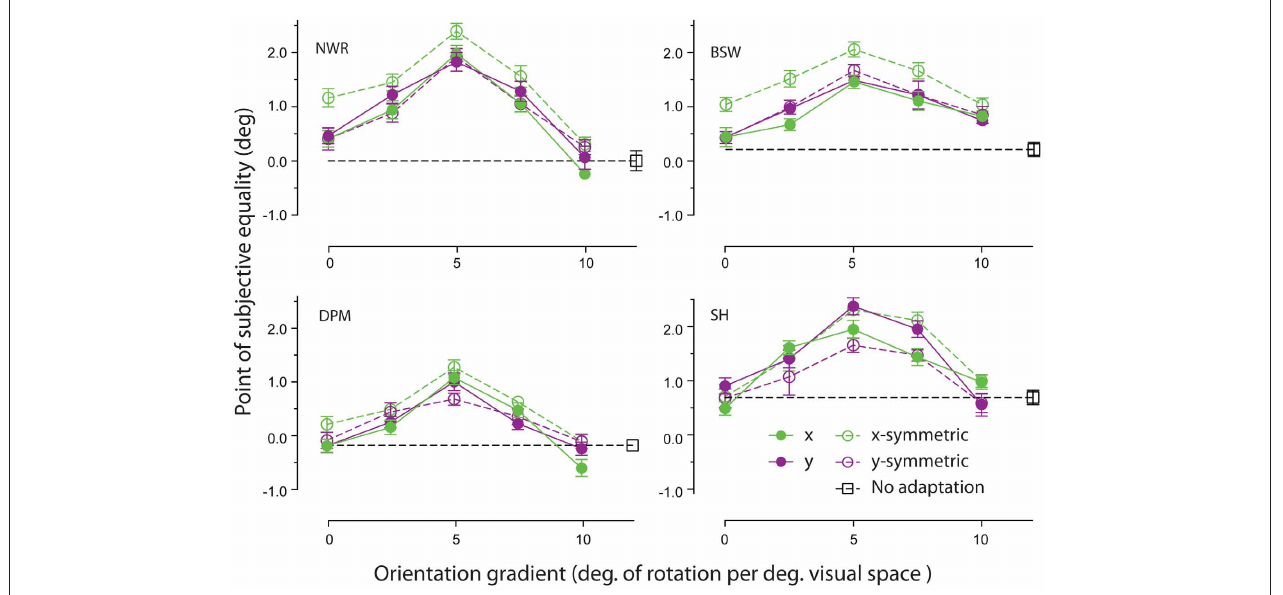
FIGURE 4 | Orientation gradient tuning of spatially remote TAEs. PSEs for each observer are plotted as a function of the rate of change of orientation in the adapting texture across space, applied either in the horizontal (green symbols) or vertical (purple symbols)